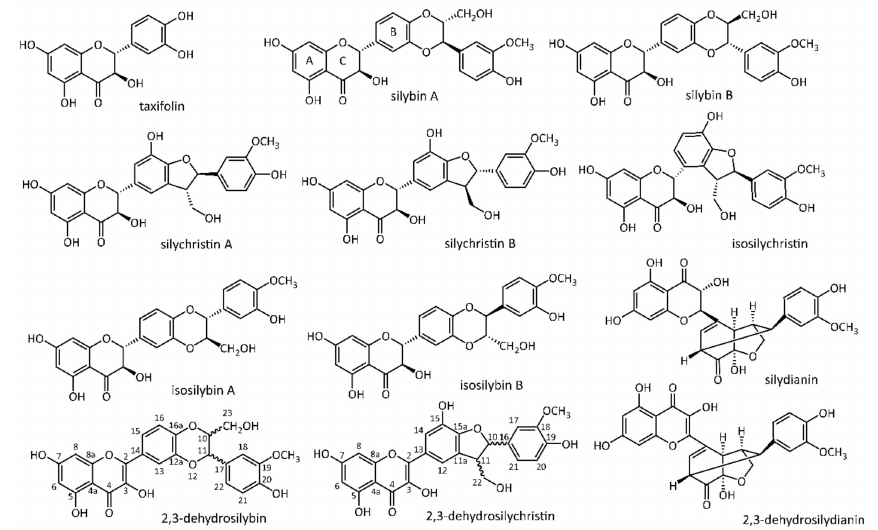
Figure 1. Structures of silymarin